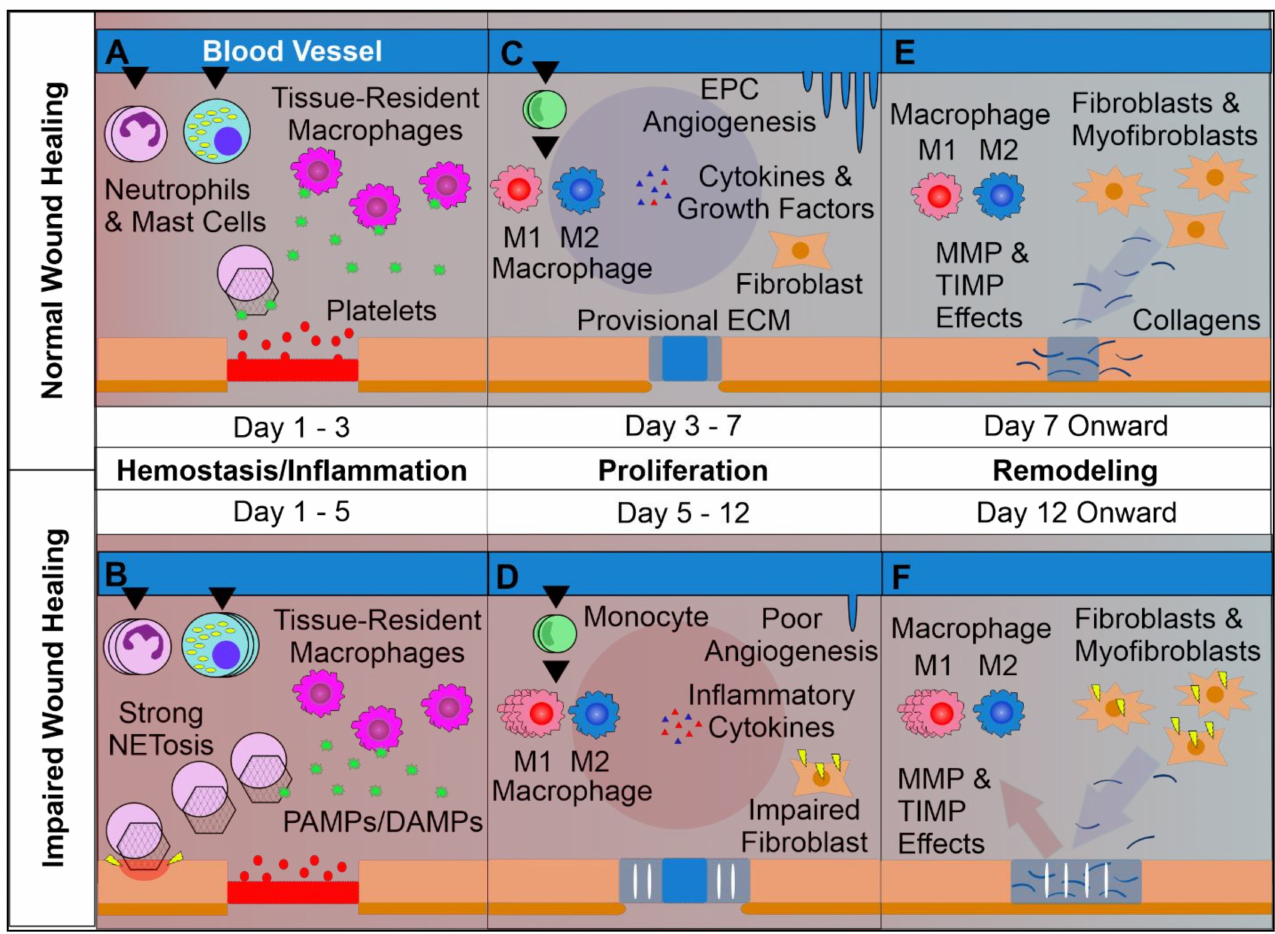
Figure 1. Overview of Normal vs. Impaired Wound Healing. ( A ): The first phase of wound healing is hemostasis. Platelets form a clot at the site of injury, and chemoattractants are released, recruiting key inflammatory cells. Next, inflammation takes charge, with infiltrating neutrophils and mast cells releasing pro-inflammatory cytokines and inducing strong sanitizing effects. This is accompanied by neutrophil extracellular trap (NETosis) induction, which assists in capturing and destroying invading pathogens. Tissue-resident macrophages react to pathogen- and damage-associated molecular patterns (PAMPs & DAMPs), activating. Later a provisional matrix comprised of fibronectin and other provisional extracellular matrix (ECM) components forms from the clot. ( B ): Impaired wounds see an upregulated influx of neutrophils and mast cells, leading to an overactive inflammatory response, causing collateral damage and extending the inflammatory phase to the detriment of subsequent phases. ( C ): Following resolution of strong inflammation, the proliferative phase begins. Crucially, endothelial progenitor cells are stimulated by growth factors to induce angiogenesis. This angiogenesis allows for wound-resident cells to be supplied with oxygen and nutrients, facilitating their function. Infiltrating monocytes differentiate into M1 and M2 macrophage subsets. M1 macrophages maintain a strong inflammatory profile, but are counterbalanced by pro-regenerative M2 macrophages which release anti-inflammatory cytokines, growth factors, and proteases which replace the provisional ECM with collagens, assisted by properly functioning fibroblasts. This process results in thick granular tissue and full keratinocyte coverage. ( D ): Impaired wounds result in poor angiogenesis and, in the case of T2DM, glycated proteins. This hypoxic environment induces oxidative stress, driving inflammatory M1 macrophage polarization and impairment of fibroblasts, resulting in poor ECM reorganization and a persistent inflammatory environment. ( E ): Remodeling is carried out by macrophages, fibroblasts, and myofibroblasts re-organizing the provisional ECM into a coherent scar structure primarily by means of matrix metalloproteinases (MMPs) and their inhibitors (TIMPs), resulting in tissue with strong tensile strength and functionality. ( F ): Impaired wound-resident cells remain ineffective and pro-inflammatory. Collagen reorganization resolves poorly, resulting in weak, non-functional skin that is apt to re-injure and potentially ulcerate, perpetually